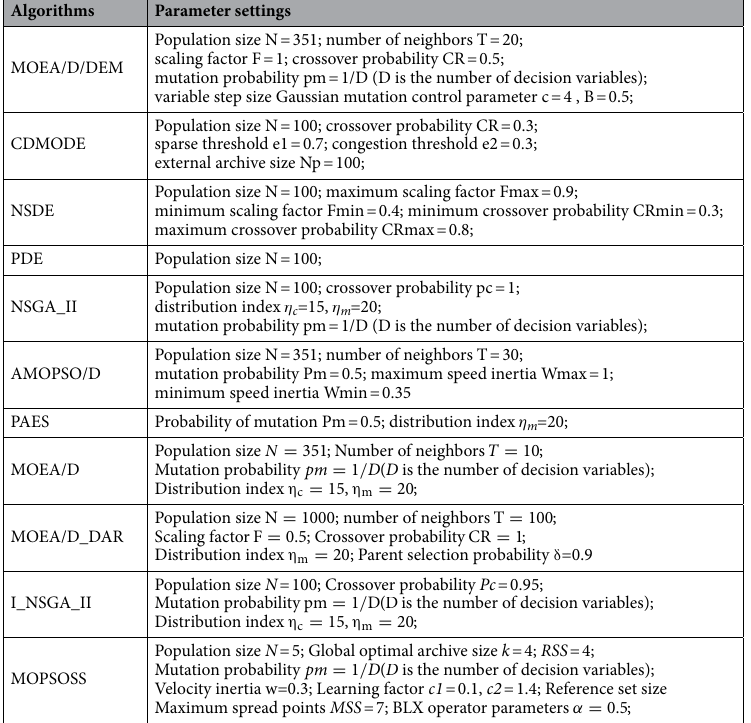
Table 5. Parameter Settings of all comparing algorithms.